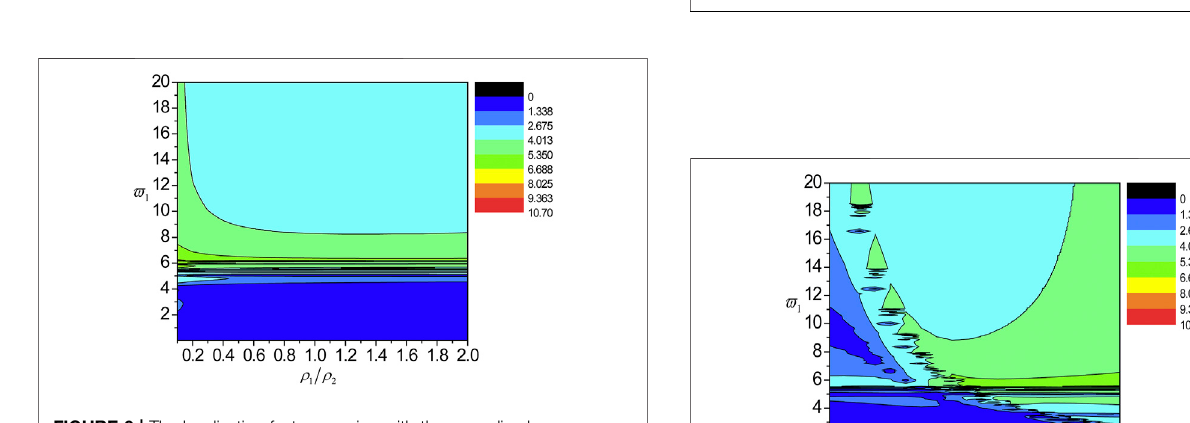
FIGURE 9 | The localization factors varying with the normalized frequency and ρ 1 / ρ 2 for the SH wave propagating normally in the nanoscale Cu/Al Fibonacci laminate for τ 1 = τ 2 = 0.18.